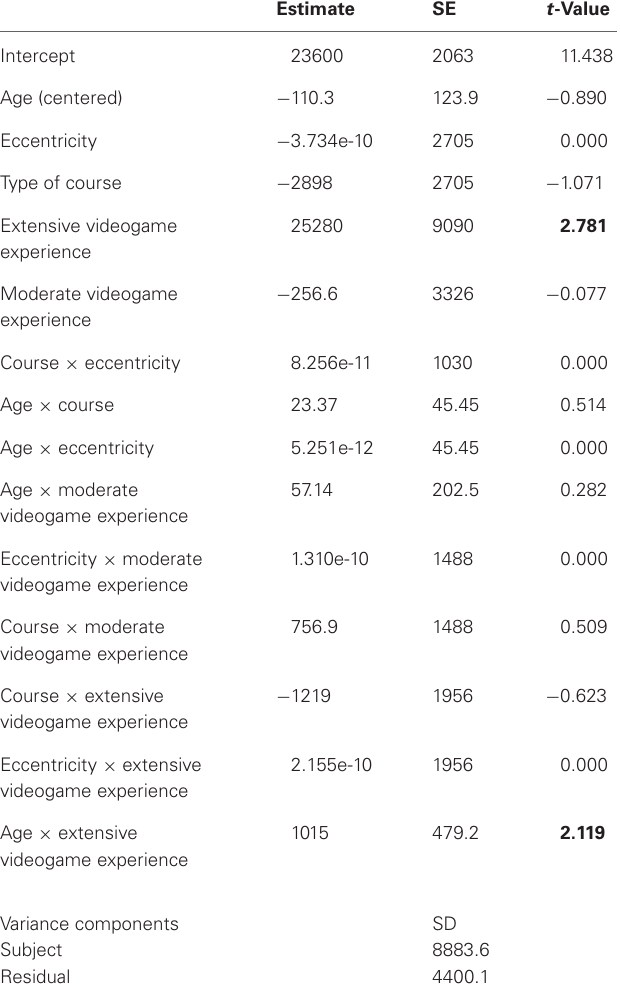
Table 5 | Linear mixed model for mean variance of horizontal eye movements on the X-axis (significant effects with t -value ± 2 in bold).